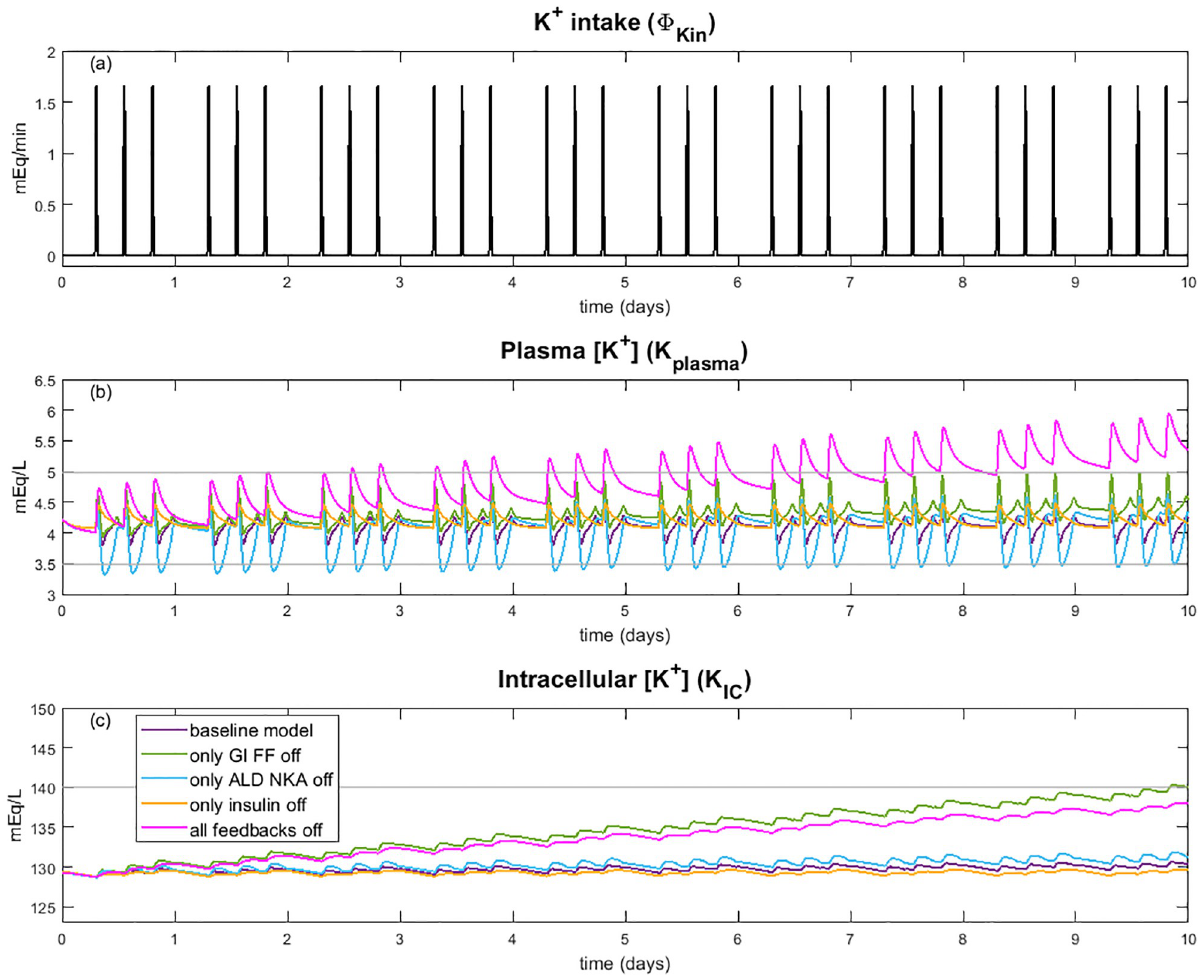
Fig 7. Effect of feedforward and feedback controls. Simulation results for plasma K + concentration (B) and intracellular K + concentration (C) for 10 days of normal K + intake ( (A) ;100 mEq/day, 3 typical meals) for the baseline model, baseline without gastrointestinal feedforward (GI FF) effect ( γ Kin = 1), baseline without the ALD effect on Na + -K + -ATPase uptake ( ρ al = 1), baseline model without insulin effect on Na + -K + -ATPase update ( ρ insulin = 1), and baseline model with all feedback effects off. Grey lines indicate normal range for K plasma and K IC